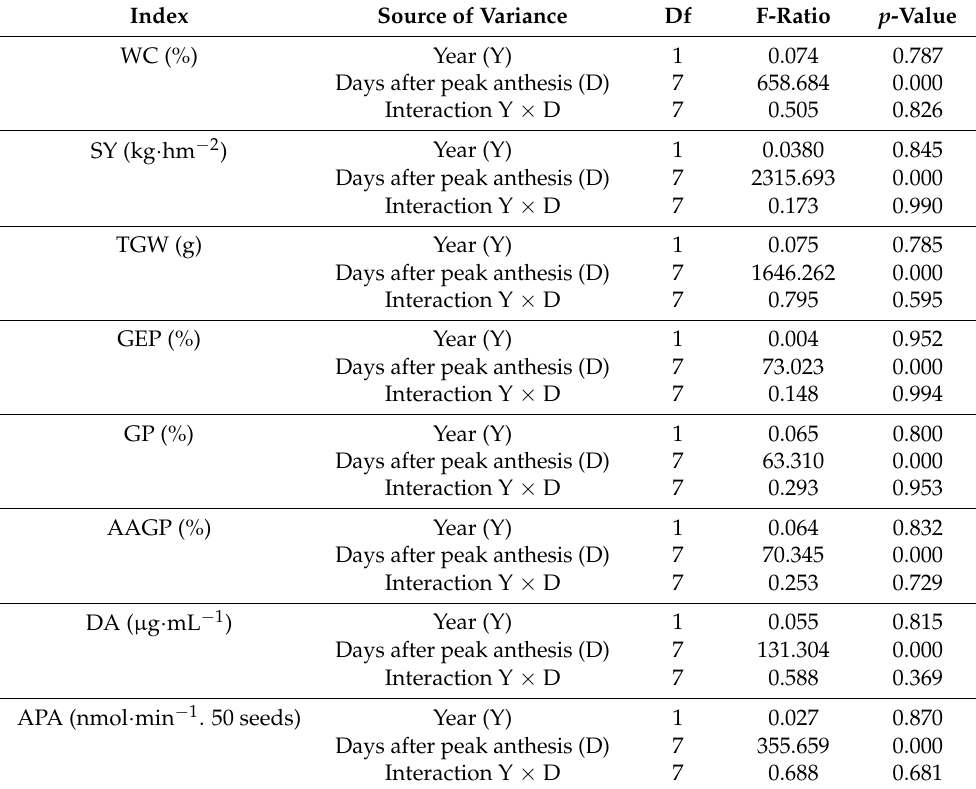
Table 1. Analysis of variance of the influence of different days after peak anthesis on harvested seed yield and quality indices of K. melanthera